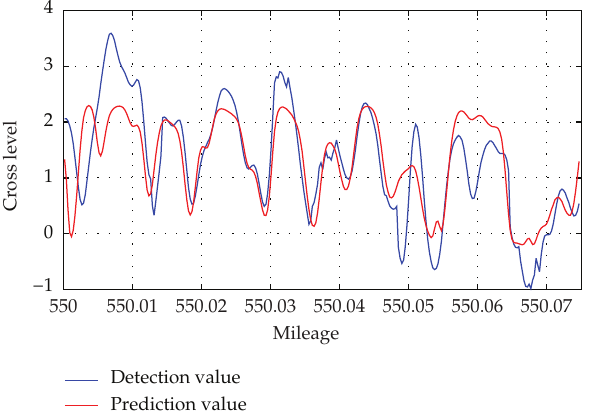
Figure 11: Comparison of the detection value and the prediction value (cid:2) Kalman filter model (cid:3)